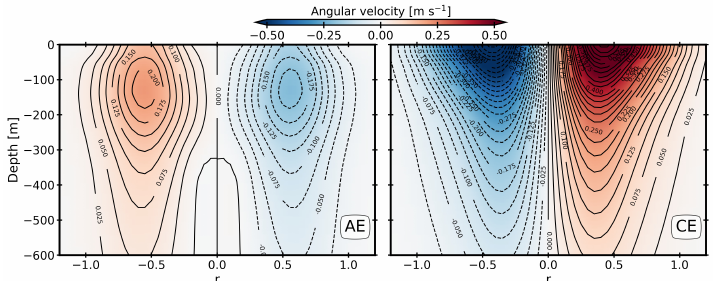
Figure 9. The angular velocity for the AE and CE. Solid and dashed contours indicate positive and negative values,